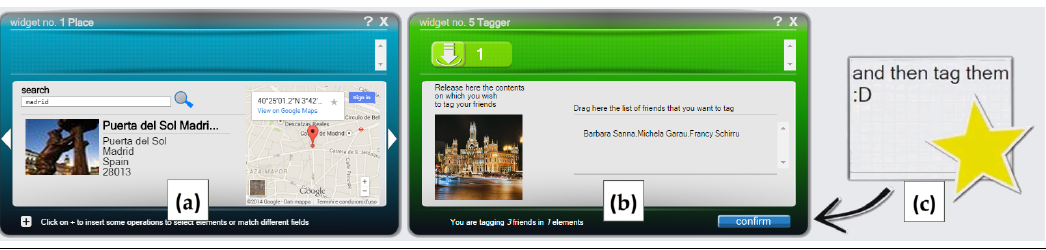
Figure 4. Examples of place ( a ) and tagger ( b ) widgets, together with a set of stickers providing help to the SNA user ( c